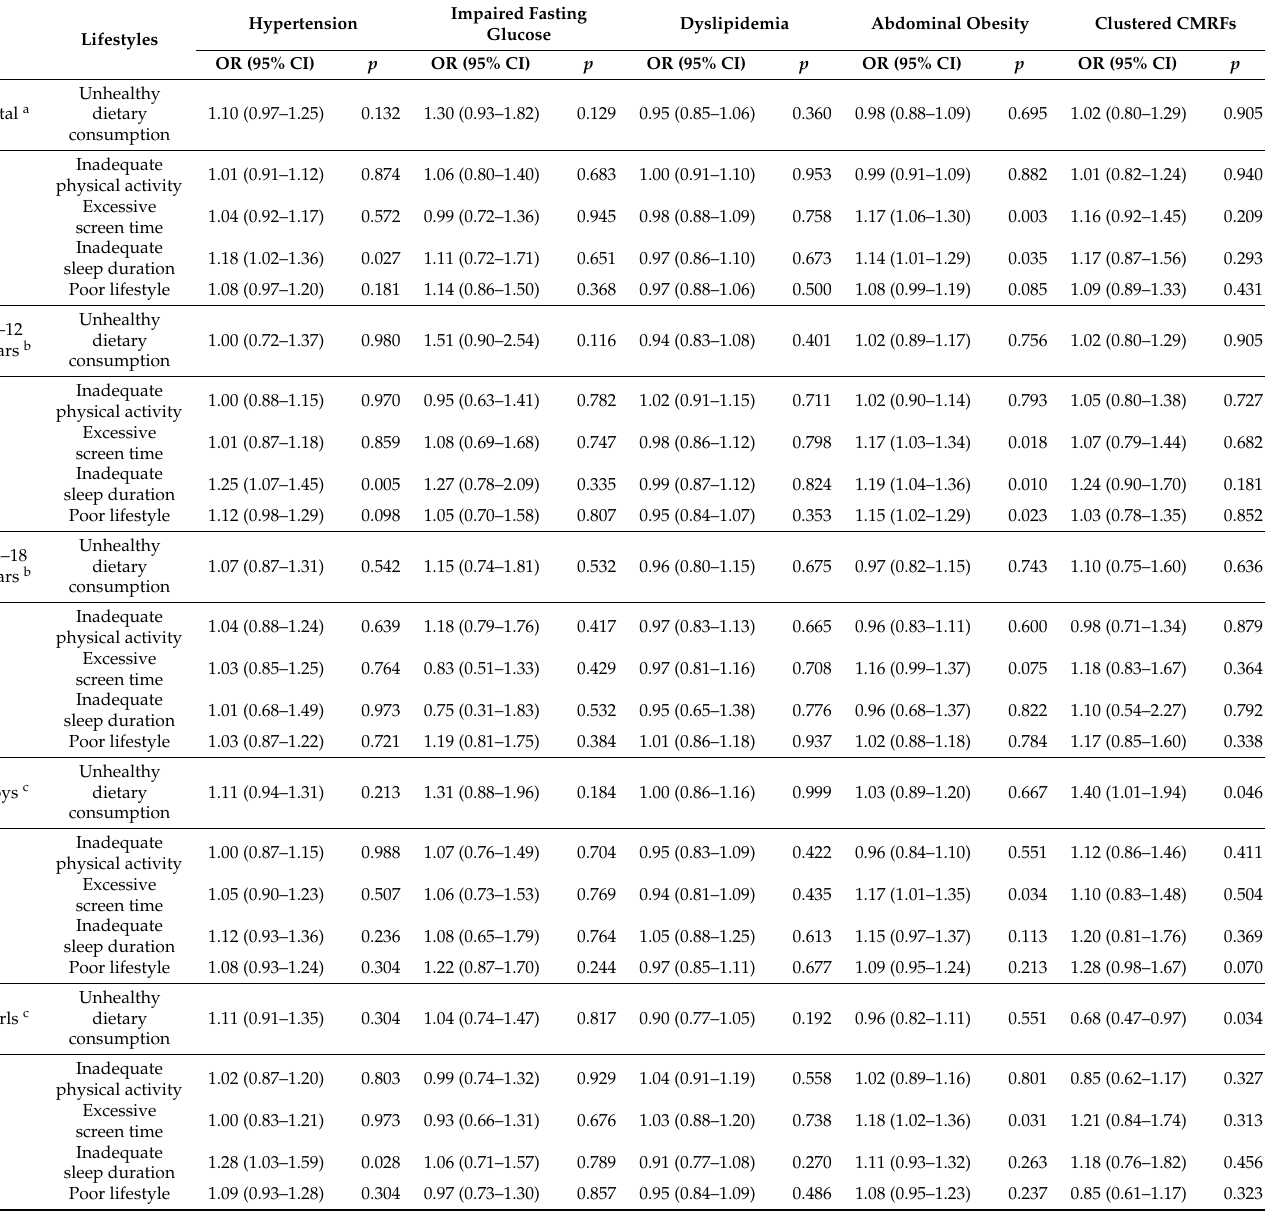
Table 4. Associations between CMRFs, clustered CMRFs and lifestyles stratified by age and sex